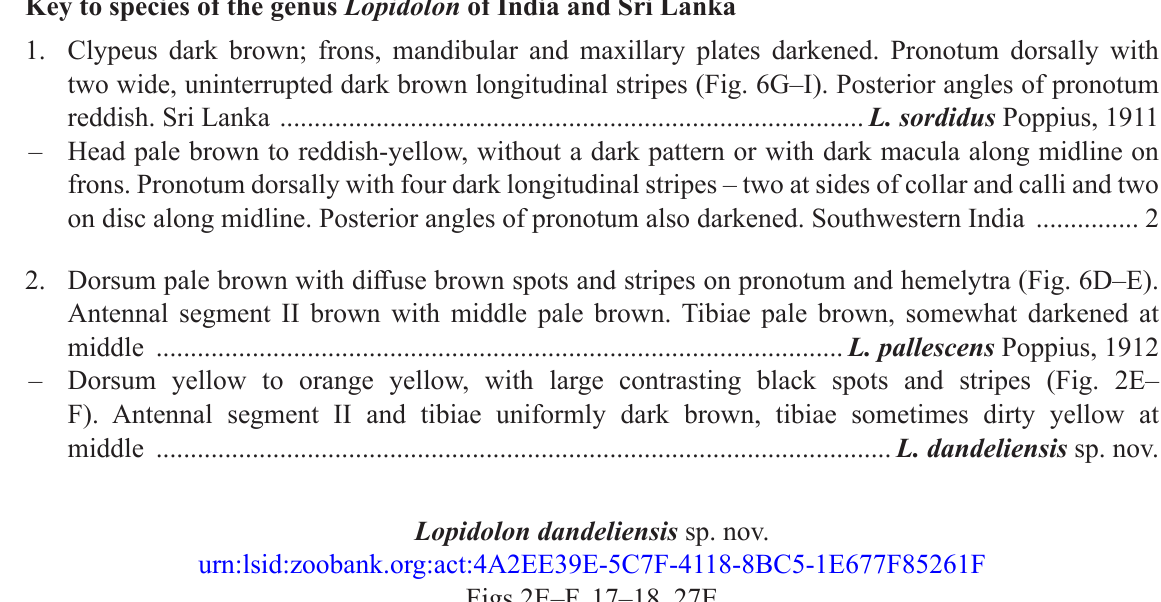
Coloration. Yellow to orange yellow, with contrasting black pattern (Fig. 2E). Head: yellow to orange- yellow, with postocular region of vertex black and sometimes with a narrow brown mark on frons